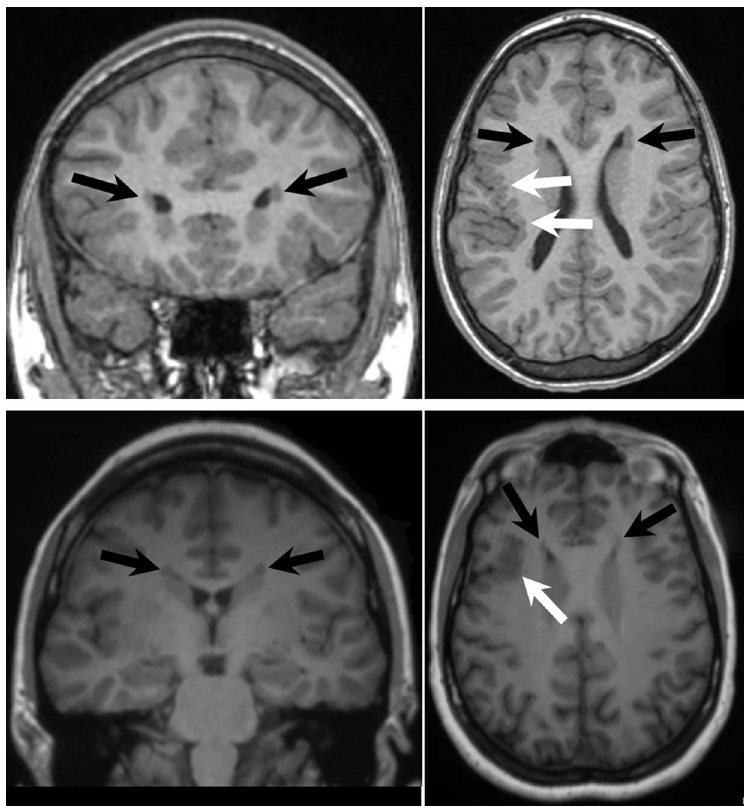
Fig 3. Brain MRI of subjects pvhnz9000cfc1 (top) and mother (bottom). Images are coronal T1-weighted (left column) and axial T1-weighted (right column). The images all show bilateral periventricular nodular grey matter heterotopia maximal in the frontal regions (black arrows). The axial images show over-folded cortex in the deep perisylvian/insular region on the right consistent with polymicrogyria (white arrows).